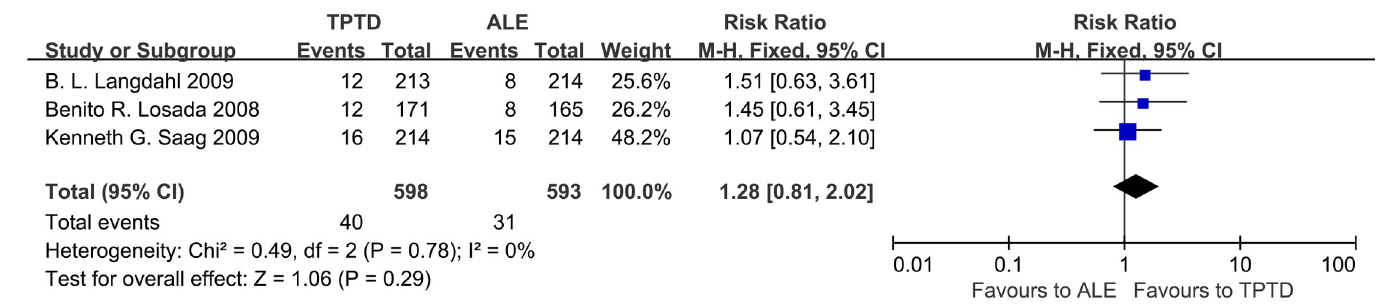
Fig 5. Forest plots of incidence non-vertebral fractures.